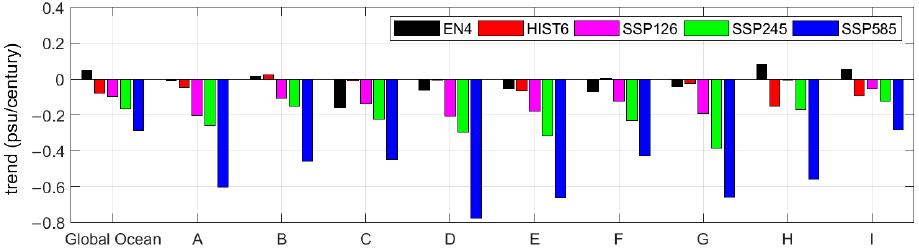
Figure 9. Trends of spatial mean sea surface salinity (SSS) in the global and each Asian Marginal Sea (unit: psu/century). The alphabetical order of A–I in the x-axis represents different Asian Marginal Seas that are marked by boxes in Figure 1. A. Bering Sea; B. Sea of Okhotsk; C. Japan/East Sea; D. East China Seas (including the East China Sea, the Yellow Sea, and the Bohai Sea, ECSs); E. the Philippine Sea; F. the South China Sea (SCS); G. Indonesian Seas; H. Bay of Bengal; and I. Arabian Sea.